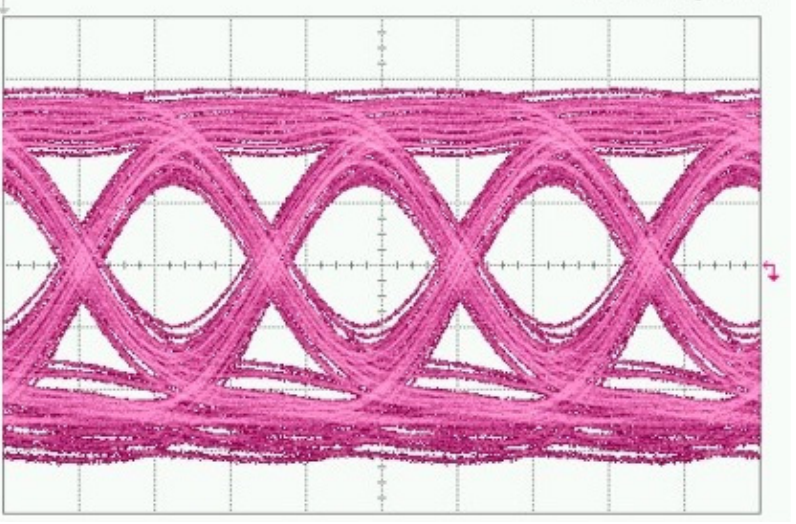
Figure 15. Eye diagram from the third-order GaN DFB LD at 2 Gbits/s showing error-free communication.